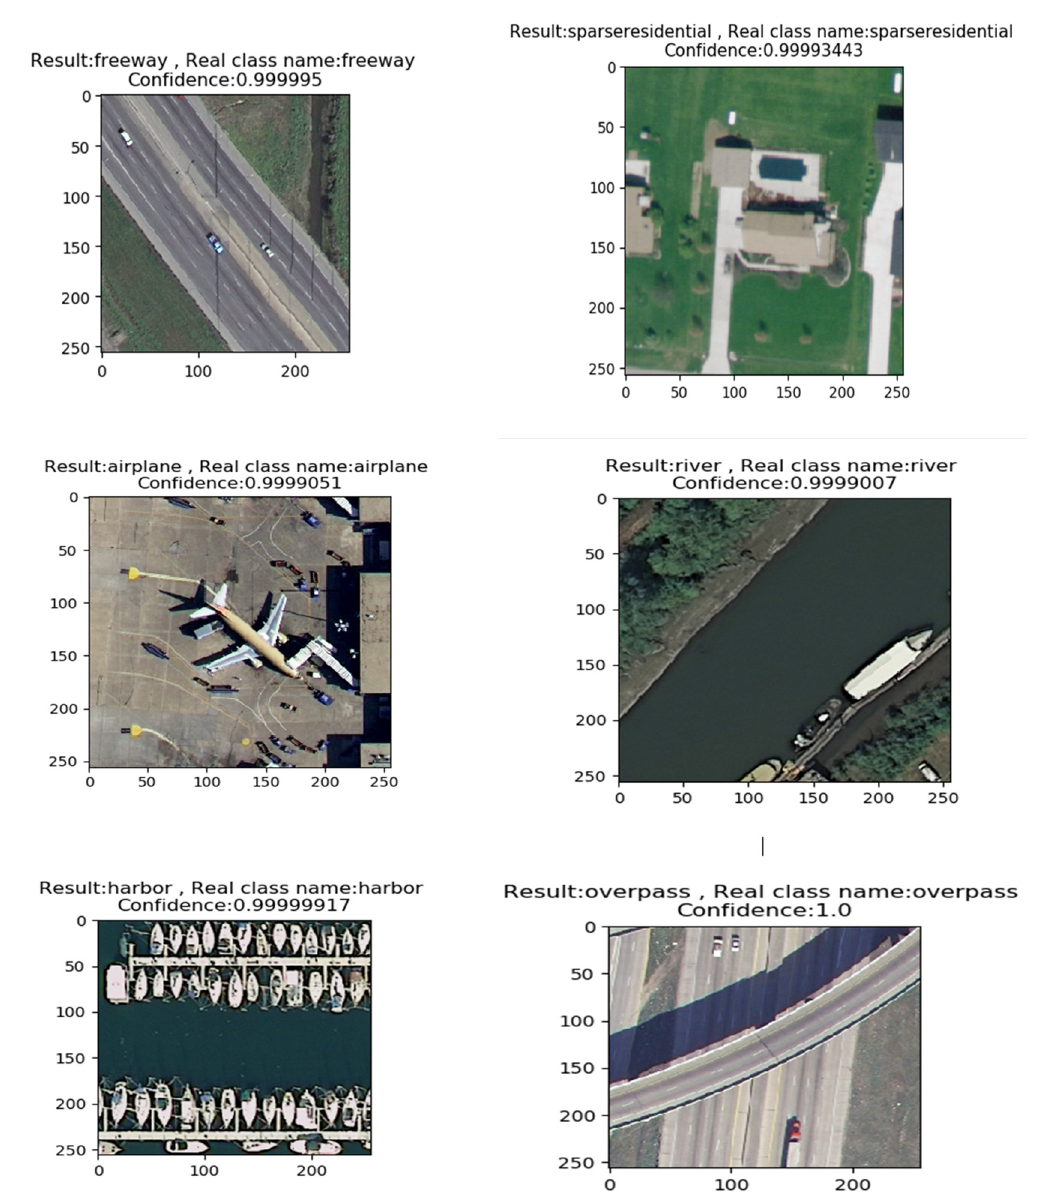
Figure 9. Random classification prediction results.